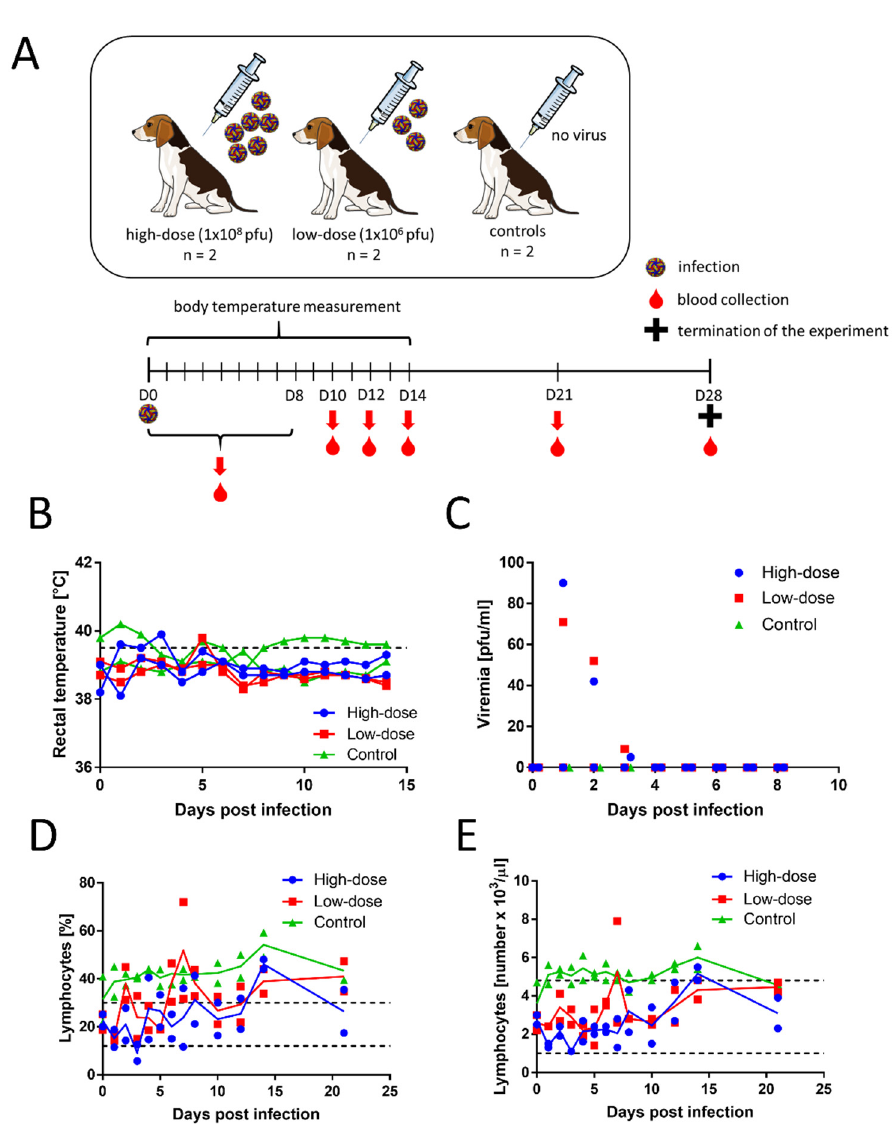
Figure 1. Experimental TBEV infections in dogs. ( A ) Experimental protocol: Six beagle dogs (females, three months old) were included. Dogs were subcutaneously inoculated with TBEV at 10 8 PFU/per dog (high-dose group, n = 2, blue circles ), TBEV at 10 6 PFU/per dog (low-dose group, n = 2, red squares ), and no TBEV (control, n = 2, green triangles ). Blood samples were collected daily on days 0–8, then on days 10, 12, 14, 21, and 28 p.i. Animals were euthanised at 28 p.i. (Figure created with Servier Medical Art, available at www.servier.com). ( B ) Individual daily rectal temperatures are shown for 14 days p.i. The dashed line indicates the threshold for fever (39.5 °C). ( C ) Individual TBEV titres measured on the indicated days, determined with plaque assays. The limit of detection was 4.7 pfu/mL. ( D , E ) Individual blood lymphocyte levels, measured with an automated haematology analyser on the indicated days, show ( D ) lymphocyte percentages and ( E ) lymphocyte counts. Dashed lines indicate the upper and lower limits for the healthy condition.